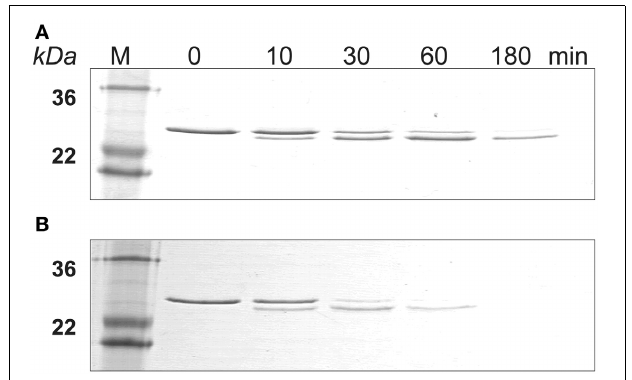
FIGURE 2 | MMP-20 digestion of amelogenin in solution and on HAP shown by SDS-PAGE. (A) Amelogenin digestion in solution. (B) MMP-20 hydrolysis of amelogenin adsorbed on HAP. M, standard molecular weight.